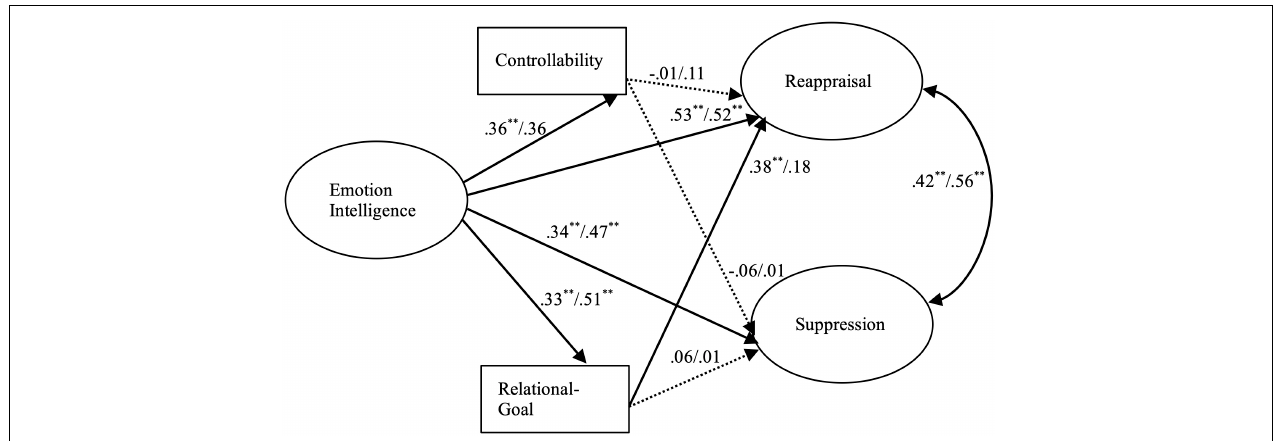
FIGURE 1 | The structural mode of emotion regulation with parents. Dashed lines indicate non-significant paths. The values are the path coefficients for females (left side) and males (right side). N = 300. ∗ p < 0.05. ∗∗ p < 0.01.